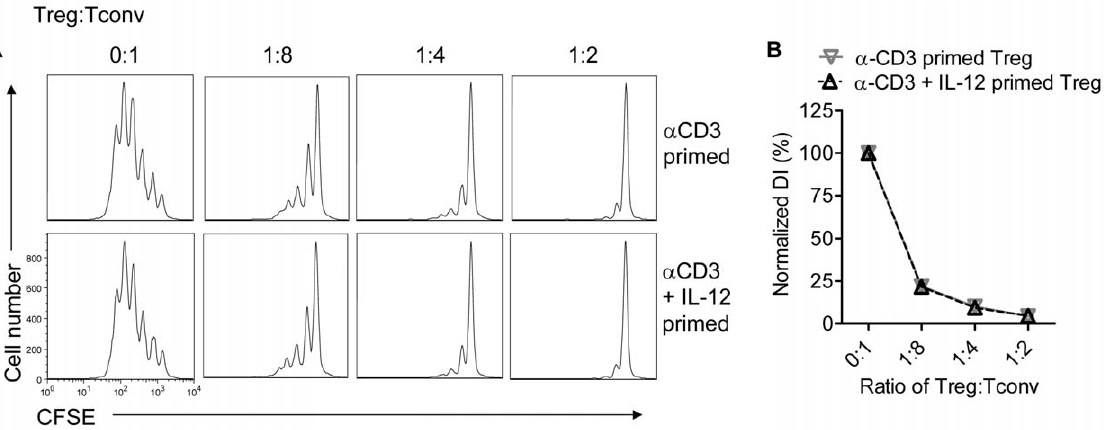
Figure 4. IFN- c - and IFN- c + Tregs are equivalently suppressive. Lymphocytes from naı¨ve Foxp3 gfp mice were treated with anti-CD3 with or without IL-12 for 66 hr. Tregs were sorted and co-cultured with CFSE-labeled Tconvs at the indicated ratios for 66 hr in the presence of irradiated splenocytes and anti-CD3 mAb. Tconvs were then analyzed for CFSE dilution. Samples were analyzed in triplicate. (A) Representative histograms are shown. (B) Normalized DI were calculated for each group. Data are from one experiment representative of 3 independent experiments.